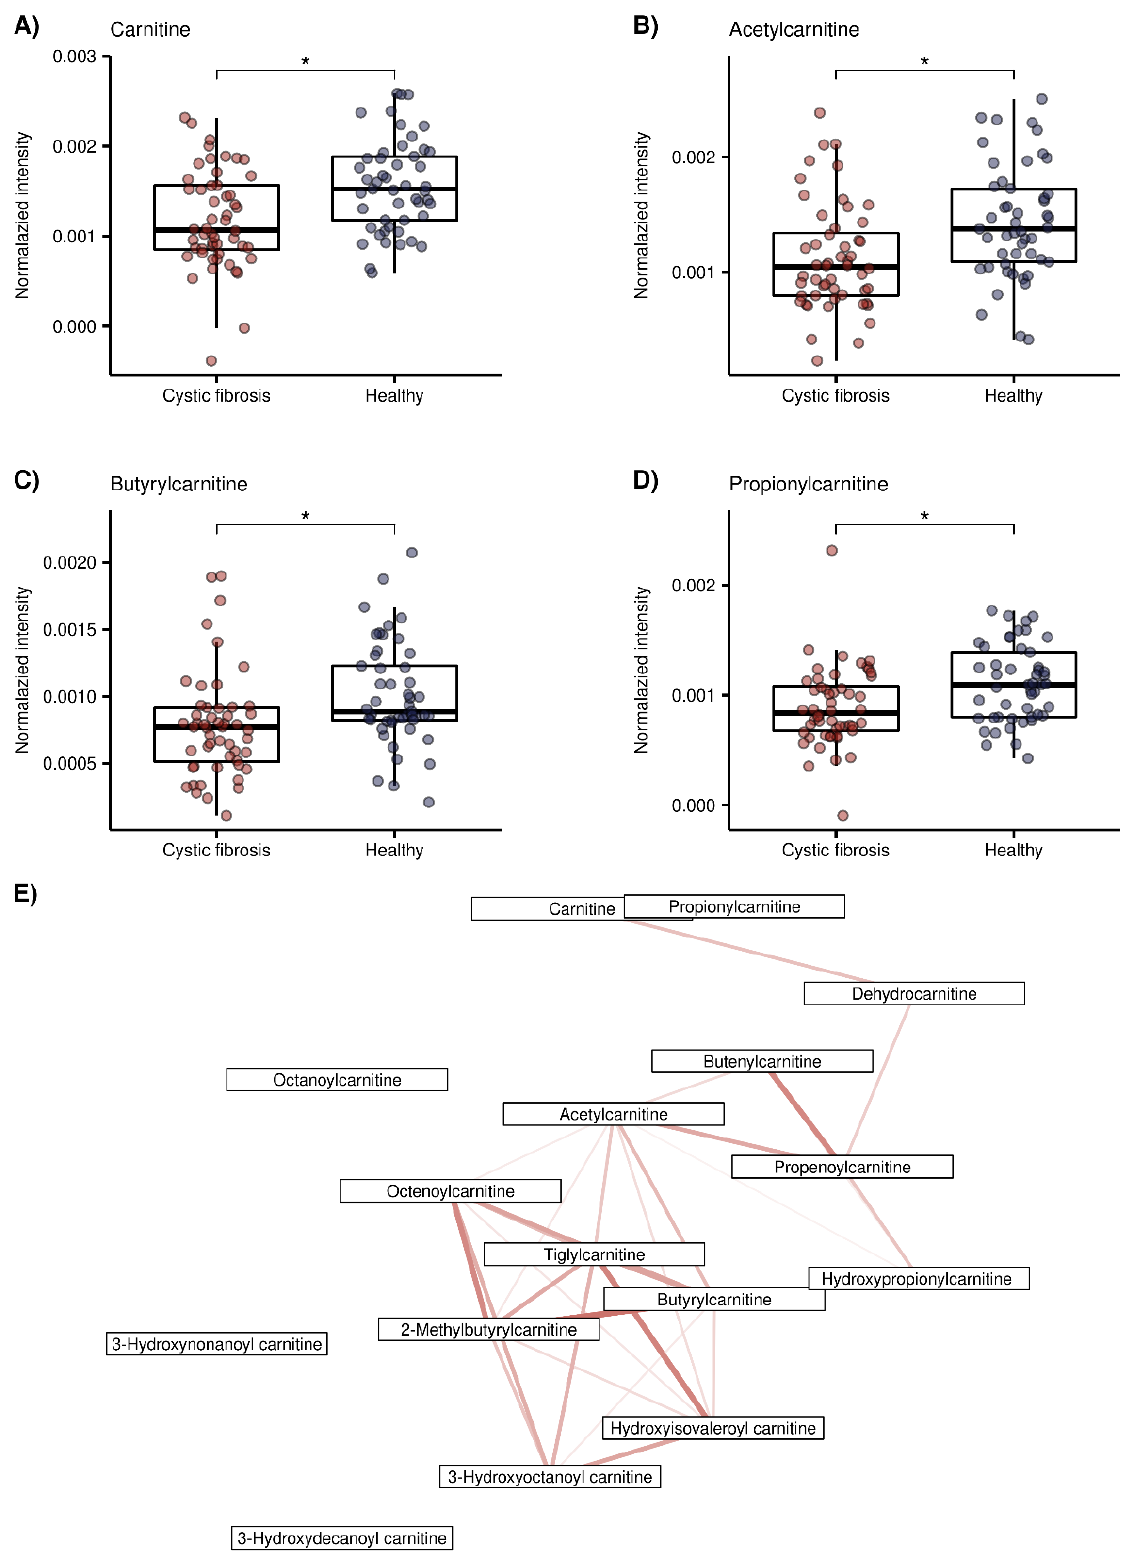
Figure 3. Exemplary box plots of 4 acylcarnitines (red = CF patients, blue = healthy controls), *: false discovery rate (FDR) adjusted p < 0.05 taken from our previous study [30]) and correlation network plot of all 16 acylcarnitines elevated in the healthy group. ( A ) Carnitine ( m/z + 162.1123), ( B ) Acetyl- carnitine ( m/z + 204.123), ( C ) Propionylcarnitine ( m/z + 218.1388, ( D ) Butyrylcarnitine ( m/z + 232.154), ( E ) Correlation network plot of the 16 acylcarnitines. Edges indicate correlations between